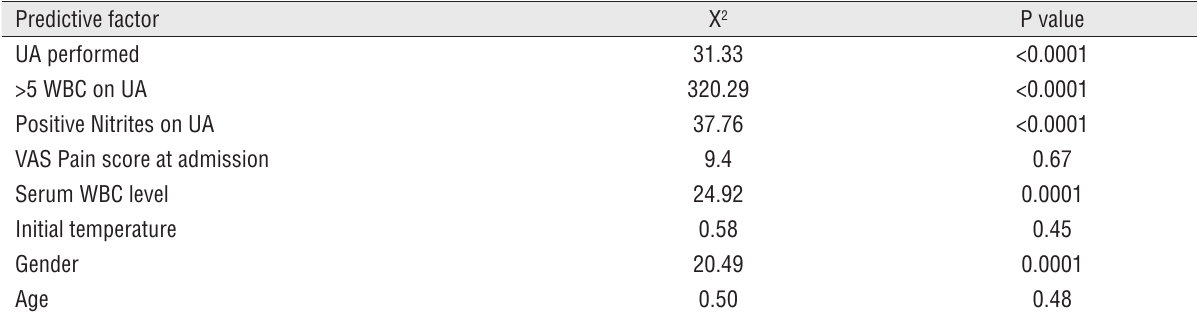
Table 3 - Multivariate analysis of positive predictors for receiving antibiotics at discharge from ED visit for nephrolithiasis. Predictive factor X